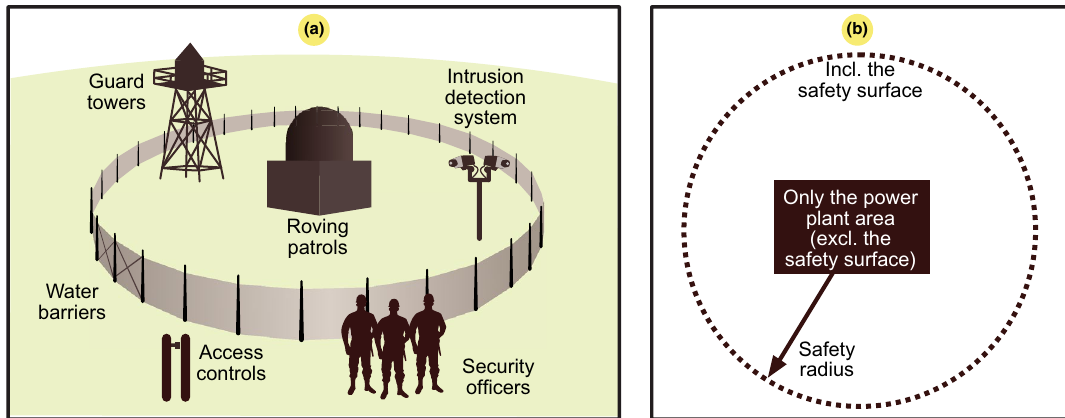
Figure 3. Security measures at a nuclear power plant to protect people and the environment in accordance with the United States Nuclear Regulatory Commission (USNRC). ( a ) Side view. ( b ) View from above indicating the safety radius including an exclusion area and a barrier space allocated in case of possible accidents.